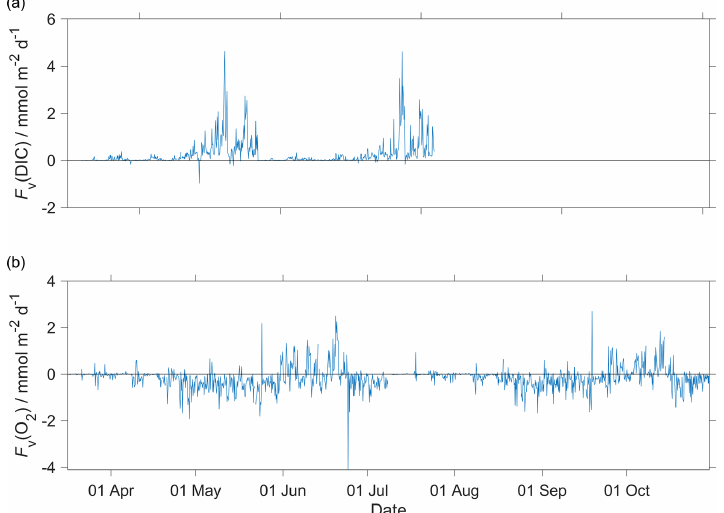
Figure A2. Diapycnal mixing ( F v ) calculated for the glider descent and ascent for (a) c (DIC) and (b) O 2 at the mixed layer depth ( z mix ) when deeper than 45m ( z lim ) and at z lim when z mix was shallower than 45m. In the calculations, we used a vertical eddy diffusivity ( K z ) of 10 − 5 m 2 s − 1 (Naveira Garabato et al.,